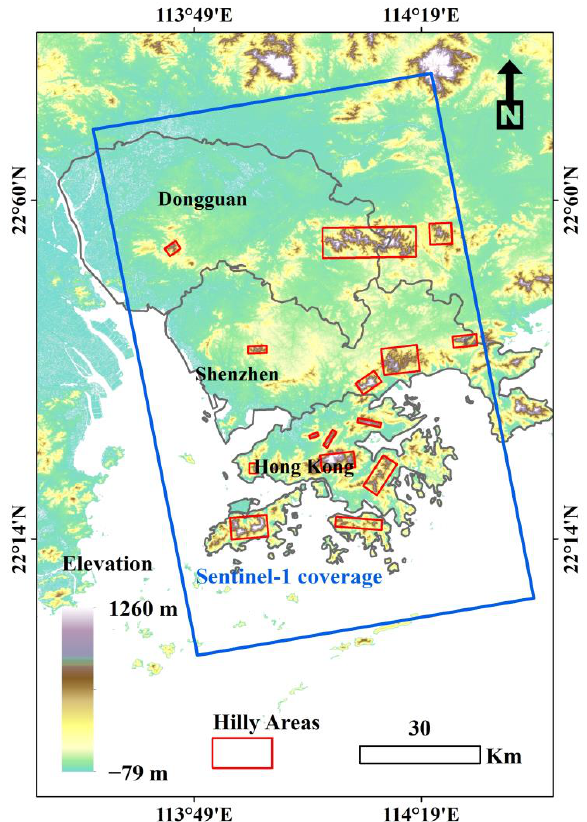
Figure 1. Topography map of the study area. The blue frame indicates the coverage of Sentinel-1 data, and the red boxes denote the hilly areas involved in the analysis of phase-elevation dependence in Section 4.4.